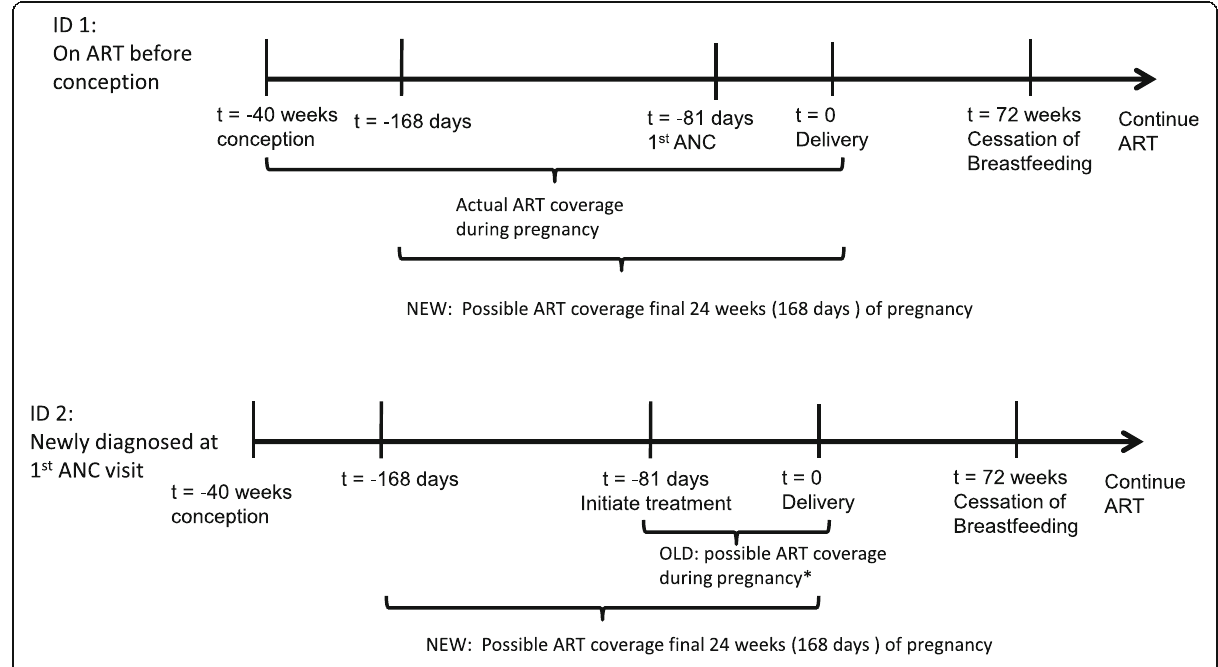
Fig. 1 Reconceiving the PMTCT Cascade of Care for women in the antenatal period